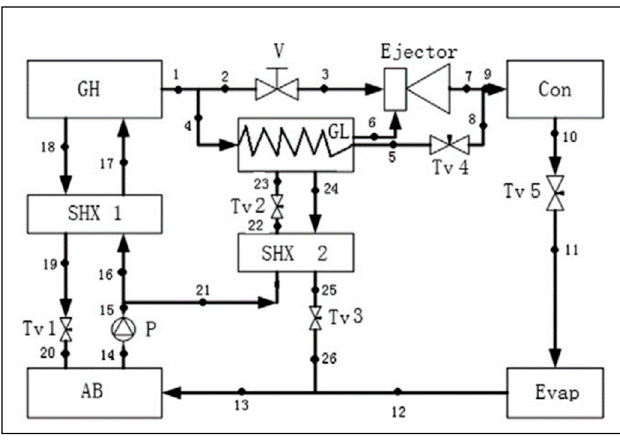
Figure 32. Ejector-absorption combined refrigeration cycle [323].